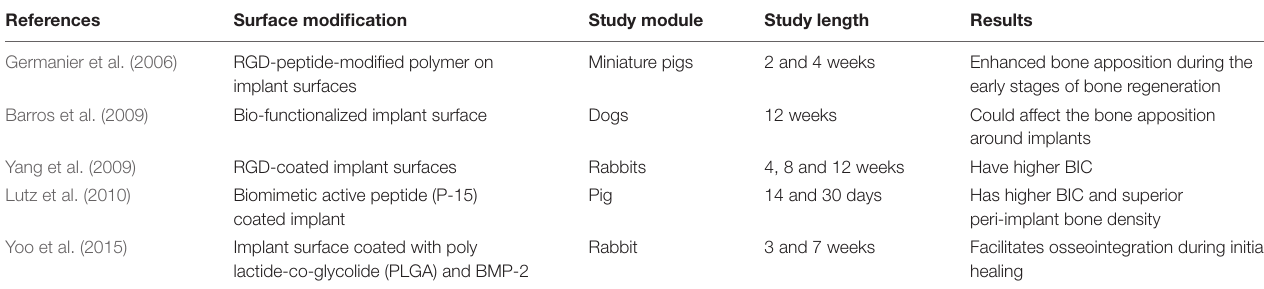
TABLE 3 | Dental implant surfaces alteration with peptides.